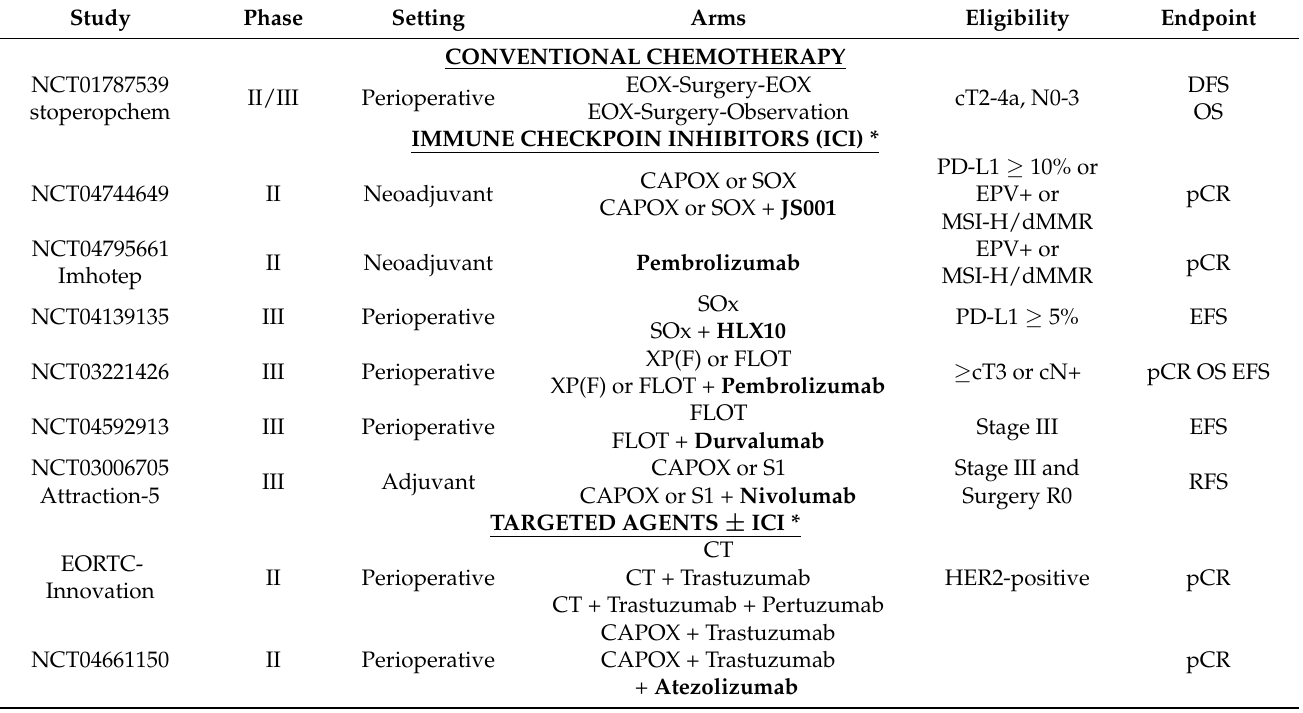
Table 3. A selection of active clinical trials in the adjuvant/perioperative treatment of resectable gastric